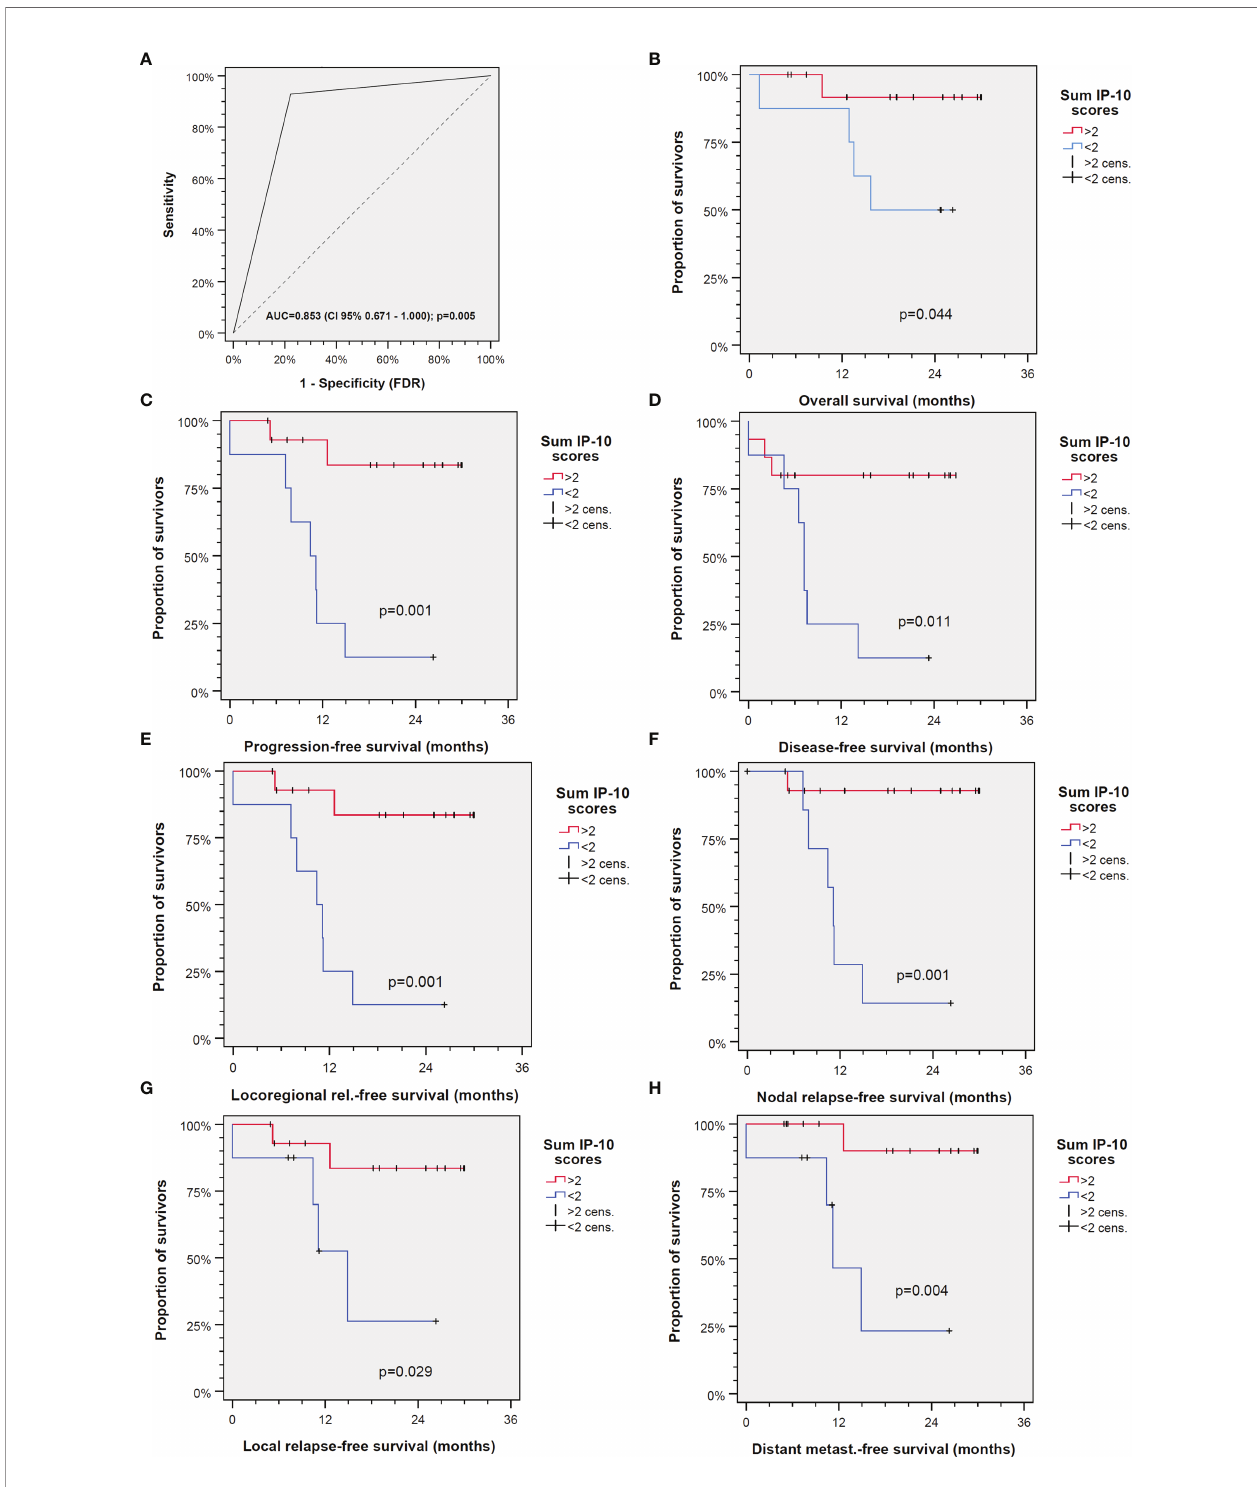
FIGURE 3 | Interferon gamma-induced protein 10 (IP-10) is able to predict outcome of head and neck squamous cell carcinoma (HNSCC) independent of the treatment applied. (A) Receiver operating characteristic (ROC) curve for the IP-10 score ( AUC , area under the curve). (B – H) Outcomes of patients with IP-10 score >2 ( red line ) versus ≤ 2 ( blue line ) for overall survival (B) , progression-free survival (C) , disease-free survival (D) , locoregional relapse-free survival (E) , nodal relapse-free survival (F) , local relapse-free survival (G) , and distant metastasis-free survival (H) . The p -values shown are from two-sided log-rank